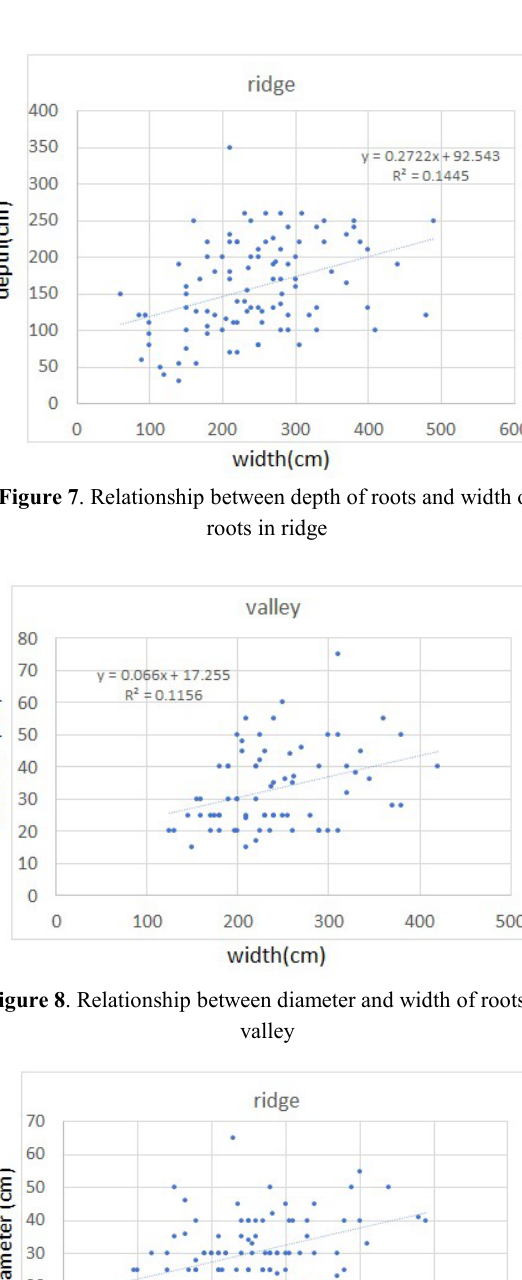
Figure 6 . Relationship between depth of roots and width of roots in valley